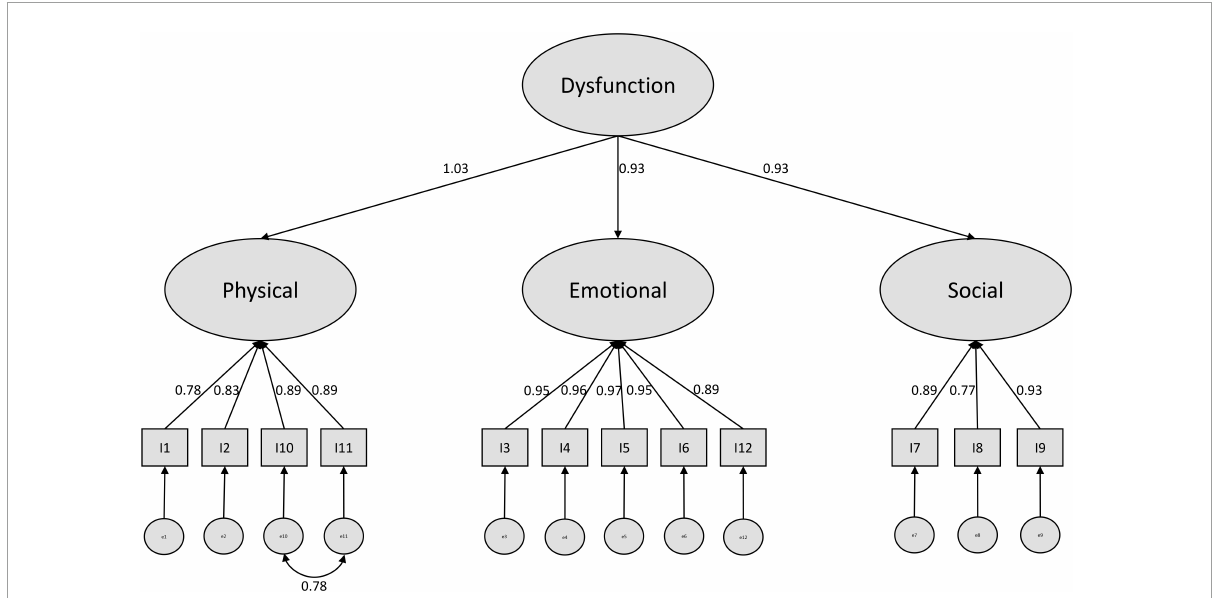
FIGURE1 Modified higher order CFA model with standardized estimates (negative